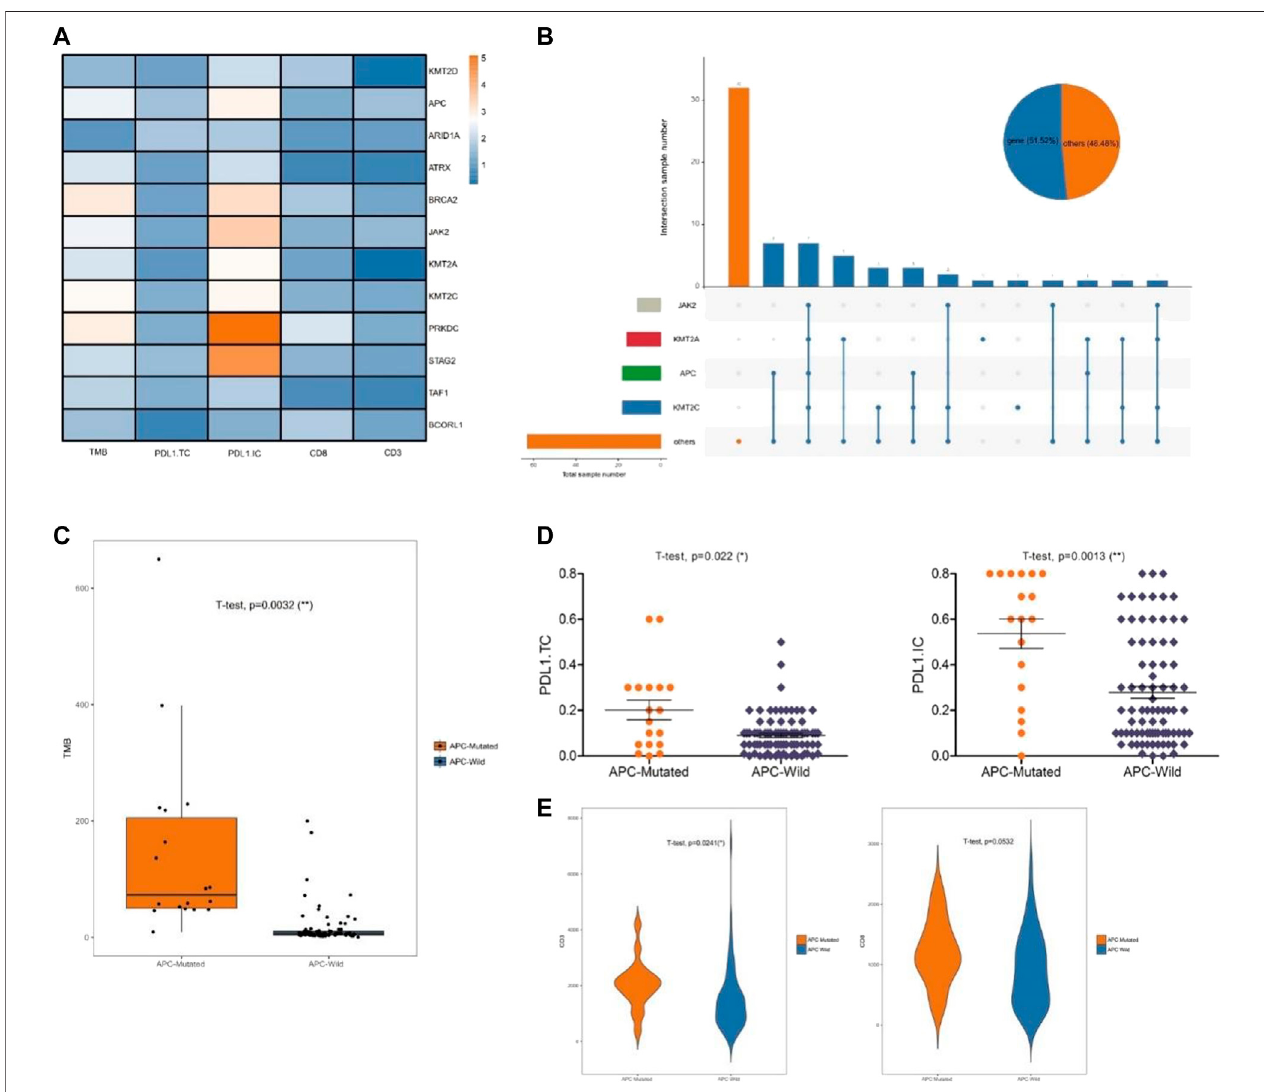
FIGURE 3 | Chromatin remodeling-related gene APC affects the immune microenvironment. (A) Signi fi cant change of TMB, PD-L1 expression, and lymphocytic in fi ltration inducing by the mutations of the discovery sets. (B) The mutations of KMT2C, APC, KMT2A, and JAK2. (C) . Relationship between APC and TMB. (D) Relationship between APC and PD-L1 expression. (E) Relationship between APC and CD3 + and CD8 + T cell in fi ltration.